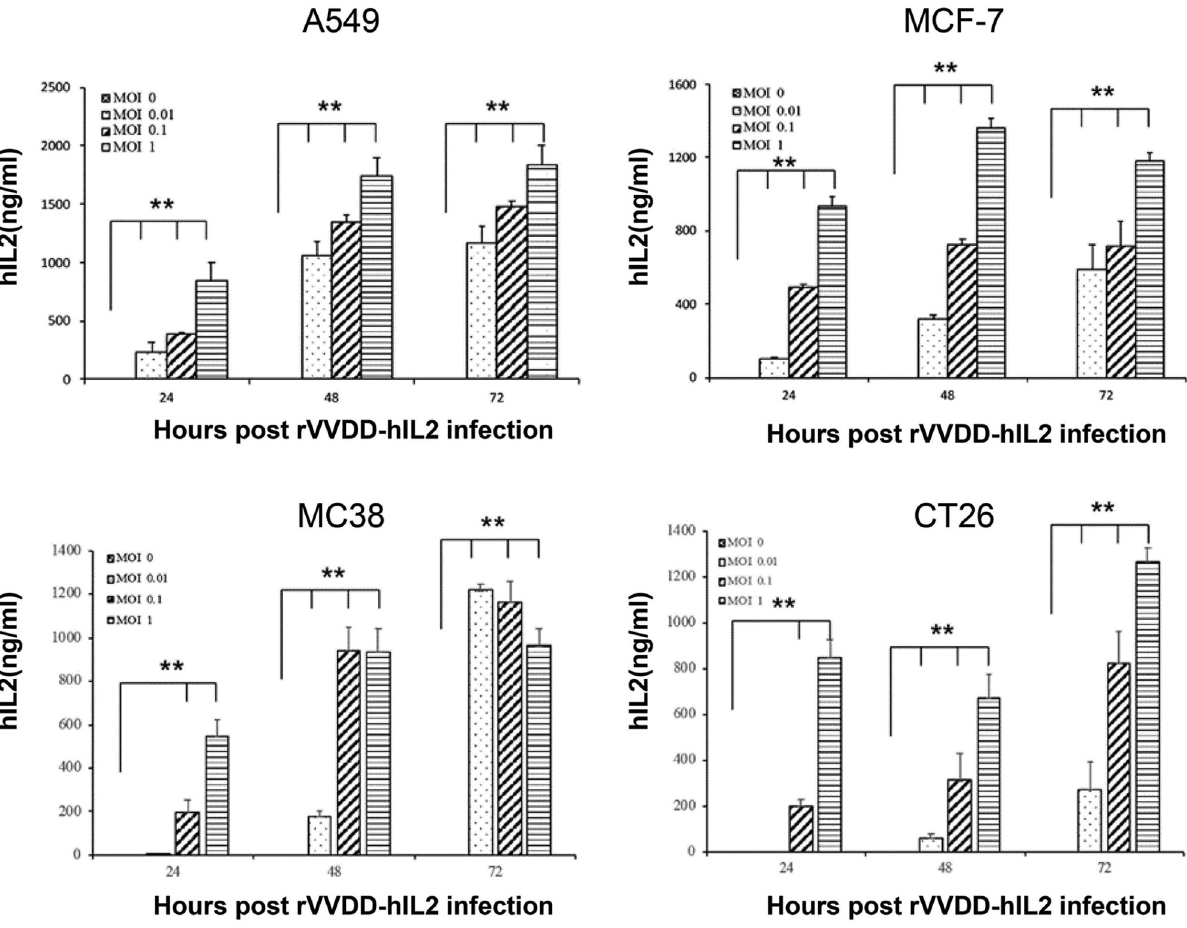
Figure 3: IL2 secretion levels in di ff erent cancer cell lines infected with rVVDD - hIL2. Cancer cells were infected with rVVDD - hIL2 at increasing MOIs ( 0, 0.01, 0.1, and 1 ) , and cell culture supernatants were collected at 24, 48, and 72 h and subjected to ELISA. Human cancer MCF - 7 and A549 and murine tumor MC38 and CT26 cells were analyzed. ** P < 0.01 compared to the MOI of 0. Data were derived from two independent experiments. All comparisons were analyzed by the student ’ s t -